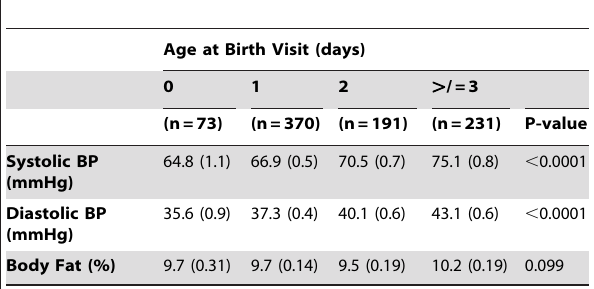
Table 4. Blood pressure in newborns by age at time of measurement during birth visit [mean (SE)], adjusting for gestational age at birth.